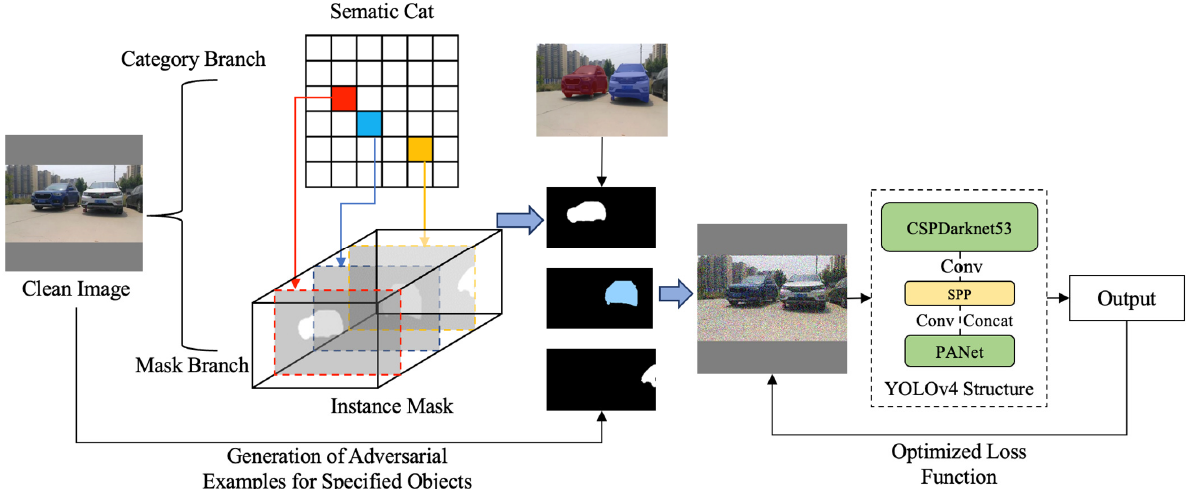
Figure 3. The framework of the proposed method. As shown in the figure, the algorithm consists of two main parts. The first part is the generation of adversarial examples for specified objects. In this part, the image is cut based on the instance segmentation algorithm. The mask defines the generation region for adversarial perturbations. The second part is a combination of a series of optimized loss functions. The full image perturbation is optimized within the restricted region, and new adversarial examples are generated.